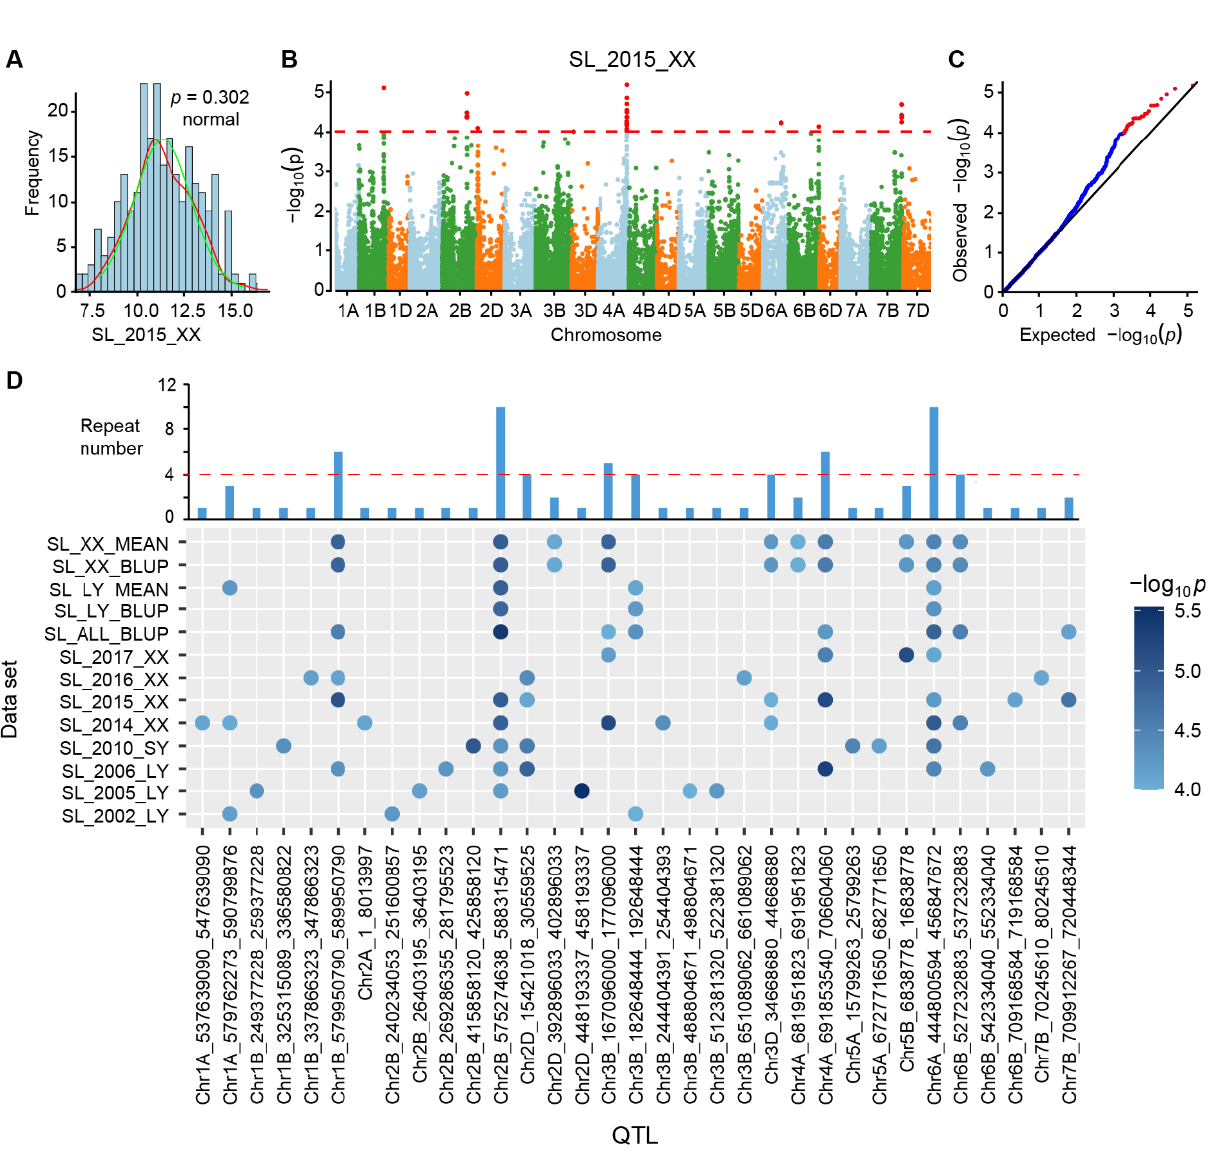
Figure 4. GWAS-derived QTL for spike length. ( A ) Spike length distribution and normal distribution test results. The red line corresponds to the normal distribution of spike length. The green line corresponds to the estimated best-fit normal density curve. ( B ) Manhattan plot of significant InDels by GWAS. Dashed line indicates the significance threshold ( − log 10 p = 4). ( C ) Quantile-Quantile plots of significant SNPs. ( D ) Duplicate information for GWAS-derived QTL. The top bar graph shows the number of repetitions, and the bottom dot graph shows the details of the detected